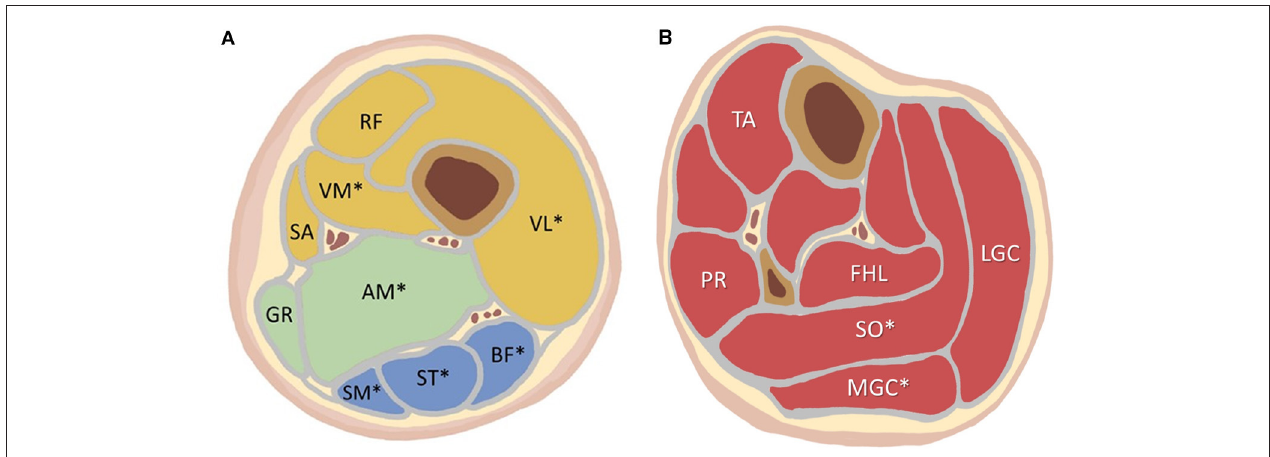
FIGURE 3 | (A) The location of each analyzed thigh muscle on the axial imaging. (B) The location of each analyzed calf muscle on the axial imaging. More than 50% of the LGMD patients showed high-grade fat substitution in the muscles marked with an asterisk (*): VL, VM, AM, SM, ST, BF, SO, MGC. LGMD, limb-girdle muscular dystrophy; VL, vastus lateralis; VM, vastus medialis; RF, rectus femoris; SA, sartorius; GR, gracilis; AM, adductor magnus; SM, semimembranosus; ST, semitendinosus; BF, biceps femoris; TA, tibialis anterior; PR, peroneus; FHL, flexor hallucis longus; SO, soleus; MGC, medial gastrocnemius; LGC, lateral gastrocnemius.